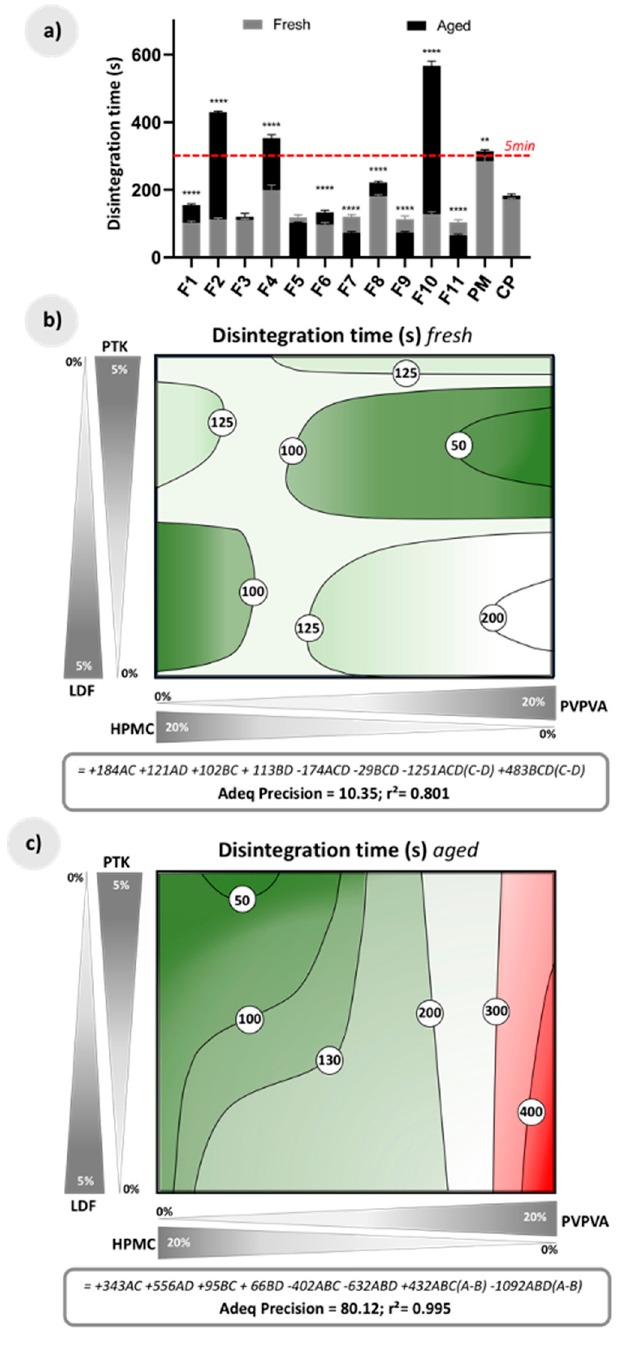
Figure 5. ( a ) Disintegration time (s) of fresh and aged physical mixture of drug and effervescent salts (PM), commercial drug product (CP), and effervescent extrudates; ( b ) Response surface for disintegration time in fresh extrudates according to a linear-cubic model, together with its predictive equation; ( c ) Response surface for disintegration time in aged extrudates according to a cubic-linear model, together with its predictive equation. A = PVPVA, B = HPMC, C = PTK, and D = LDF. The red dotted line in ( a ) marks the pharmacopoeial limit; the green regions in ( b and c ) show compositions within the sanitary limit, and the red regions in ( c ) indicate compositions outside this limit. **** ( p < 0.0001), ** ( p < 0.005).